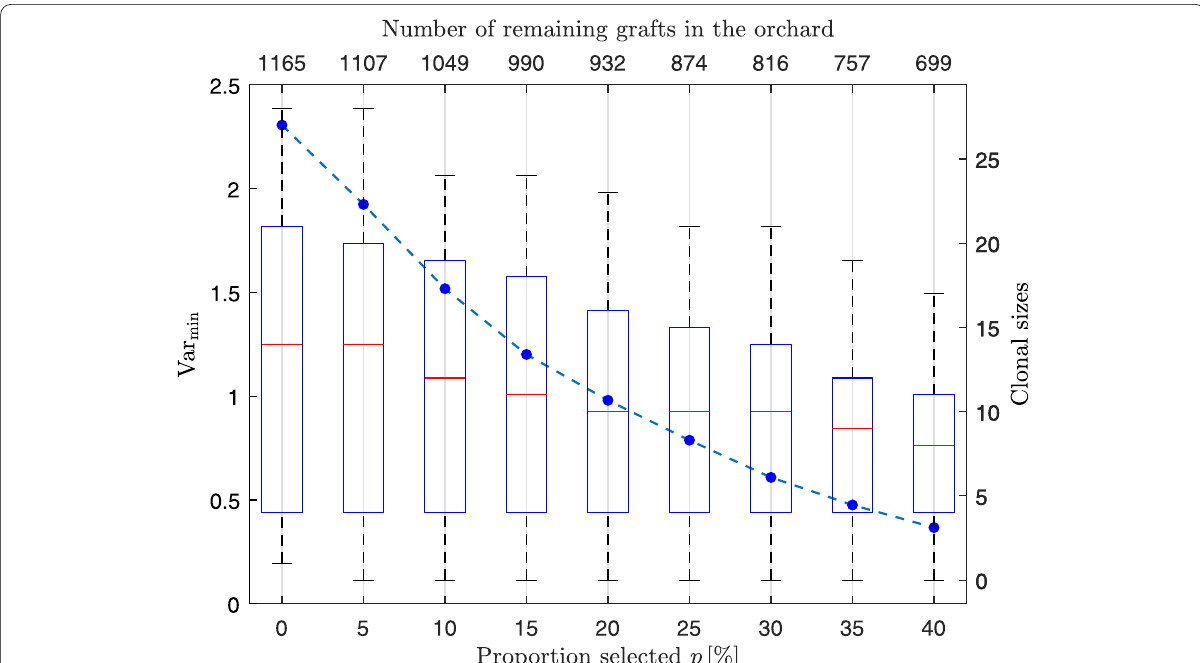
Fig. 6 The Var min criterion (Y-axis) of the seed orchard Doubrava in the Czech Republic following the genetic thinning, with 0–40% ramets removed from the orchard (proportion selected, X-axis). The number of remaining trees (grafts) is provided on the secondary X-axis. The distribution of clonal sizes is shown on the secondary